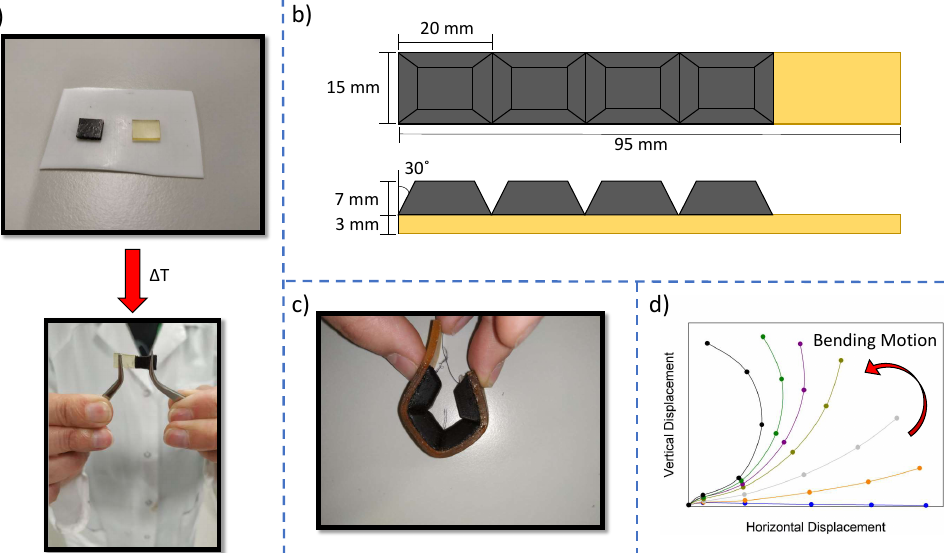
Figure 7. ( a ) Multi-material connectivity between BMI689-F400 (yellow) and Humins-DA (black) by healing two pieces together at 60 °C for 1 h. ( b ) Schematic representation of the multi-material robotic finger assembly. ( c ) Robotic multi-material finger built showing high flexibility. ( d ) Bending tendon-driven motion test of the prepared robotic finger. The blue curve corresponds to the finger position at rest, whereas the black curve corresponds to the final bent position. The rest of the curves, that is, orange, grey, dark yellow, purple and green, describe the finger transition from the position at rest to the bent state.